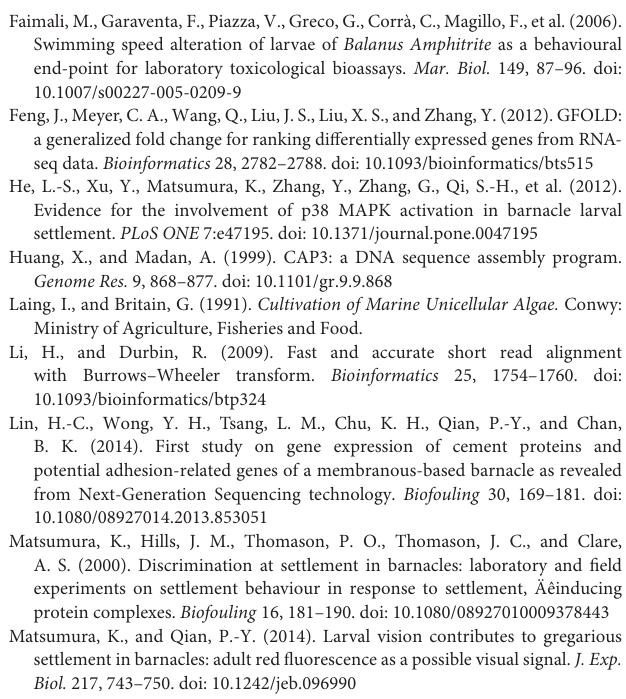
Table S1 | Transcription factors in Down-regulated genes from planktonic to sessile stage. Table S2 | Top differentially up-regulated proteins between Nauplius II and Nauplius VI. Table S3 | Top differentially down regulated proteins between Nauplius II and Nauplius VI. Table S4 | Top differentially up regulated proteins between Nauplius VI and Cyprid. Table S5 | Top differentially down regulated proteins between Nauplius VI and Cyprid. Table S6 | Top differentially up regulated proteins between Nauplius II, Nauplius VI and Cyprid. Table S7 | Top differentially down regulated proteins between Nauplius II, Nauplius VI and Cyprid. Table S8 | Primers used to design the validation interested genes. Figure S1 | Most frequent down-regulated GO terms between Nauplius II and Nauplius VI. P -values are indicated on the right side. GO terms have been chosen based on hyper geometric test ( P < 0.01) and most frequent terms. Figure S2 | Top frequent Pfam protein domains in up and down regulated genes between Nauplius II and Nauplius VI. Figure S3 | Most frequent up-regulated GO terms between Nauplius VI and Cyprids. P -values are indicated on the right side. GO terms have been chosen based on hyper geometric test ( P < 0.01) and most frequent terms. Figure S4 | Top frequent Pfam protein domain in up and down regulated genes between Nauplius VI and Cyprid. Figure S5 | Down-regulated transcription factors from Nauplius II to Nauplius VI following by up regulation in